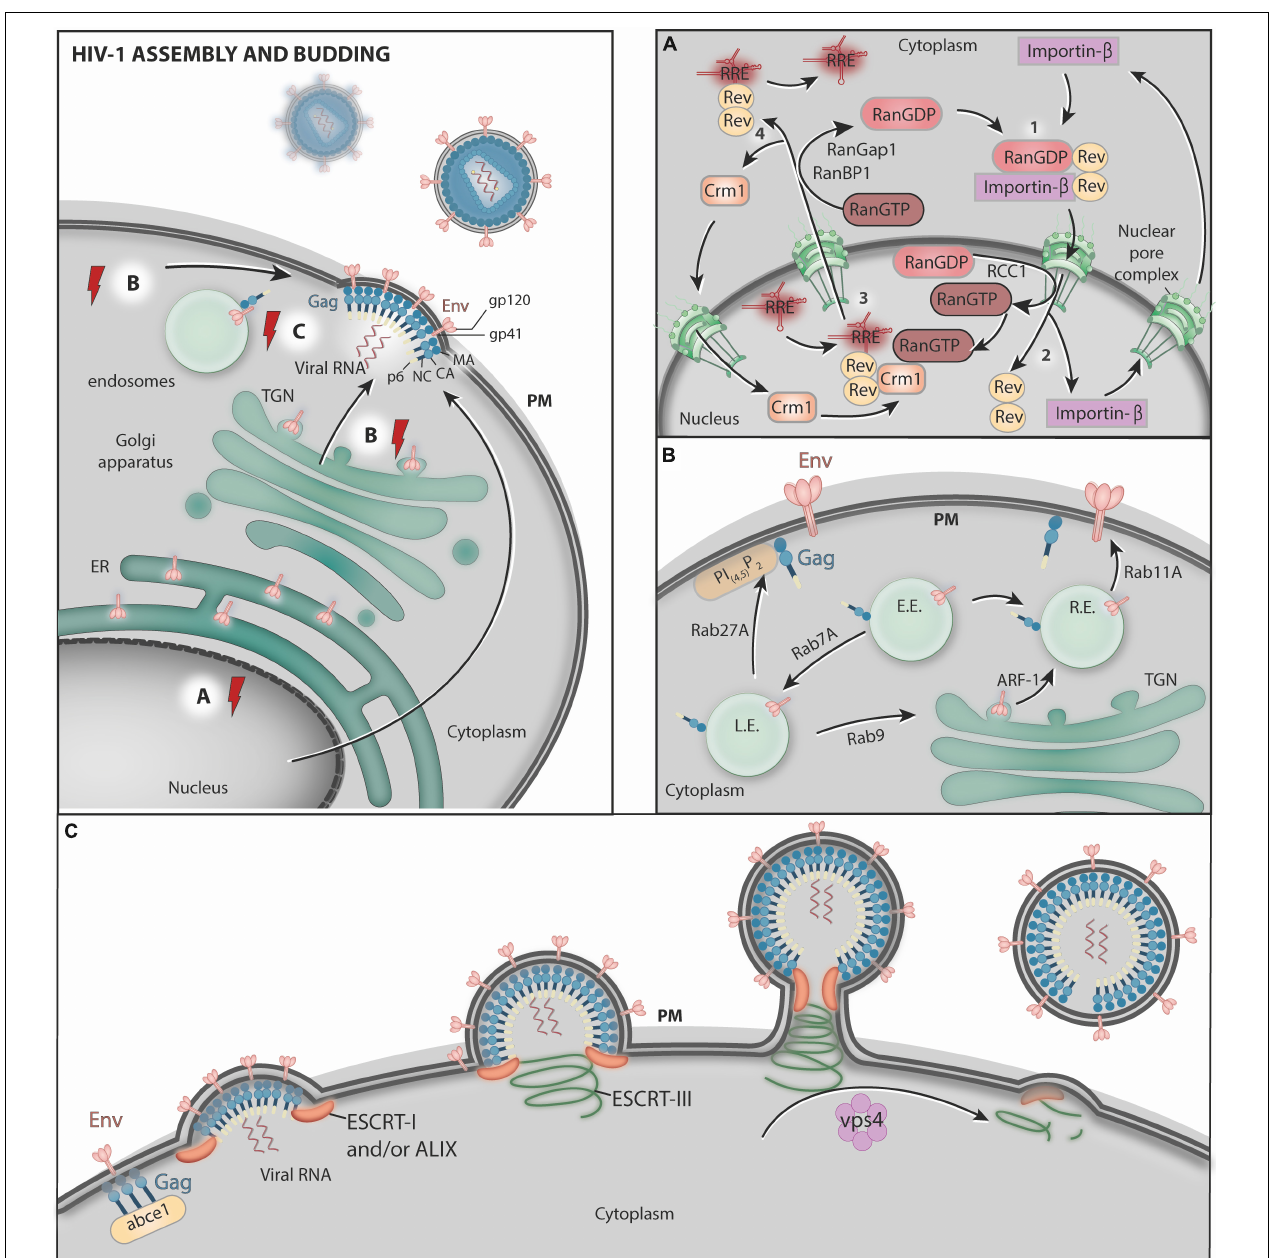
FIGURE 2 | HIV-1 assembly and budding. (A) The host transcriptional machinery transcribes the viral genes. After synthesis in the cytoplasm, Rev associates with RanGDP and Importin- β , forming the complex Rev-Importin- β -RanGDP which is imported into nucleus through nuclear pores (step 1). In the nucleus, the conversion of RanGDP to RanGTP mediated by RRC1 disassemble Rev from Importin- β , allowing Importin- β to be exported back to the cytoplasm (step 2). Rev then binds RRE (present in viral RNA molecules), RanGTP, and Crm1 and the Crm1-RanGTP-Rev-RRE complex exits the nucleus through the nuclear pores (step 3). After the translocation to the cytoplasm, RanGTP is converted to RanGDP by RanGAP1 and RanBP1, allowing the disassembly of the complex, and Crm1 is imported again to the nucleus while transported viral RNAs are free to be translated (step 4). (B) Env is synthesized in association with the ER membrane and transported to the Golgi complex. After reaching the Golgi, Env is transported to the PM, where new HIV-1 particles are formed. This trafficking occurs via transport vesicles that require ARF-1 GTPase. Rab GTPases control several steps of HIV-1 structural protein trafficking in endosomes. Rab7A is required for mature Env incorporation into nascent virus particles. Rab9 was proposed to Env and Gag from the endolysosomal pathway back to the Golgi complex. This process reroutes HIV-1 proteins to virus assembly sites at the PM. Rab11 controls the pathway that recycles Env from the cell surface to endosomes and back to the PM. Rab27a activity helps to target Gag to virus assembly sites at the PM. Moreover, Rab8 and Rab7L1 (Rab29) activity are exploited by HIV-1 during trans -infection from dendritic cells (DCs) to target T cells via virological synapses (not shown). L.E., late endosomes; E.E., early endosomes; R.E., recycling endosomes. (C) Finally, ABCE1 facilitates Gag organization at the cell surface, where the ESCRT machinery and the AAA-ATPase VPS4 facilitate virus particle release. The red electric ray symbols represent critical steps in the transport of viral factors that require energy.